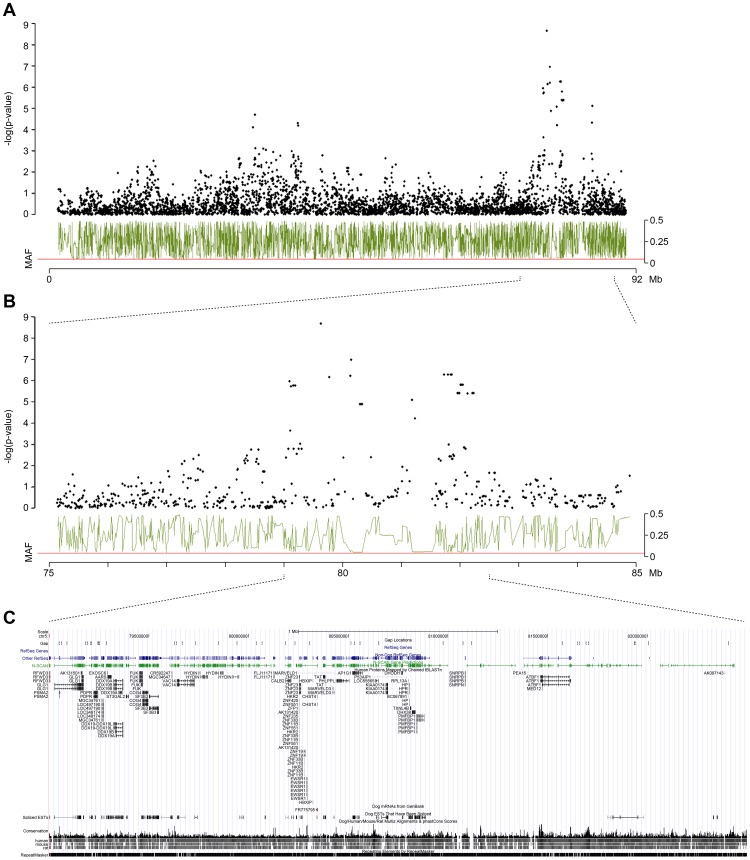
Results of the genome-wide association study restricted to SNP markers located on CFA5.(A) GWAS in the cohort of 161 Labradors showed a significant association of the elevated A. siro specific IgE levels in 136 A. siro IgE-positive dogs and 25 A. siro IgE-negative dogs. (B) Associated SNP markers (black) and minor allele frequency (green) at the locus of the IgE-responsiveness to A. siro zoomed into the interval between 75 Mb and 85 Mb. (C) The gene content of the 3.5-Mb chromosomal interval estimated according to the dog build 2 and displayed using UCSC Genome Browser (http://genome.ucsc.edu).